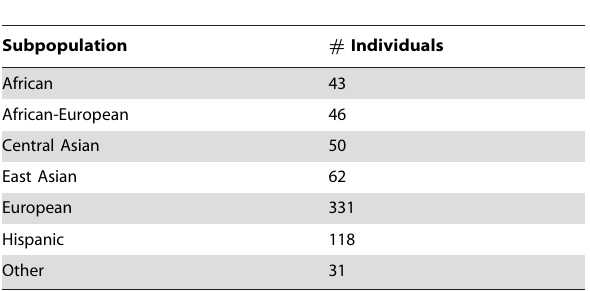
Table 1. Ancestry-based